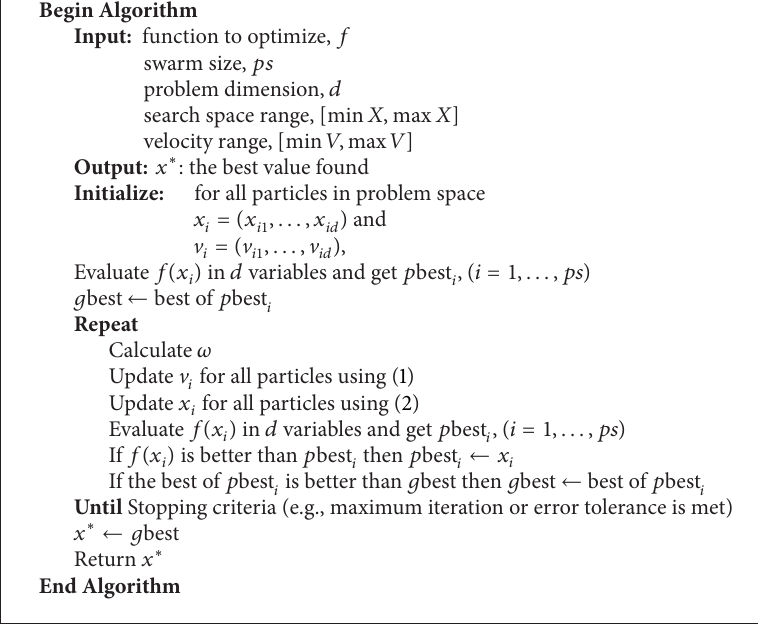
Algorithm 3: Inertia weight PSO